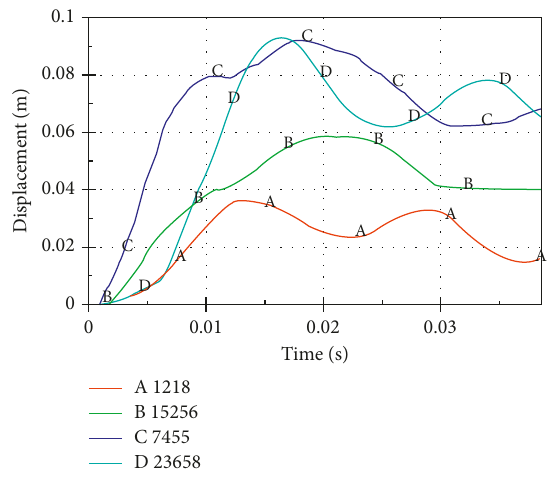
Figure 10: Deflection-time curves of the